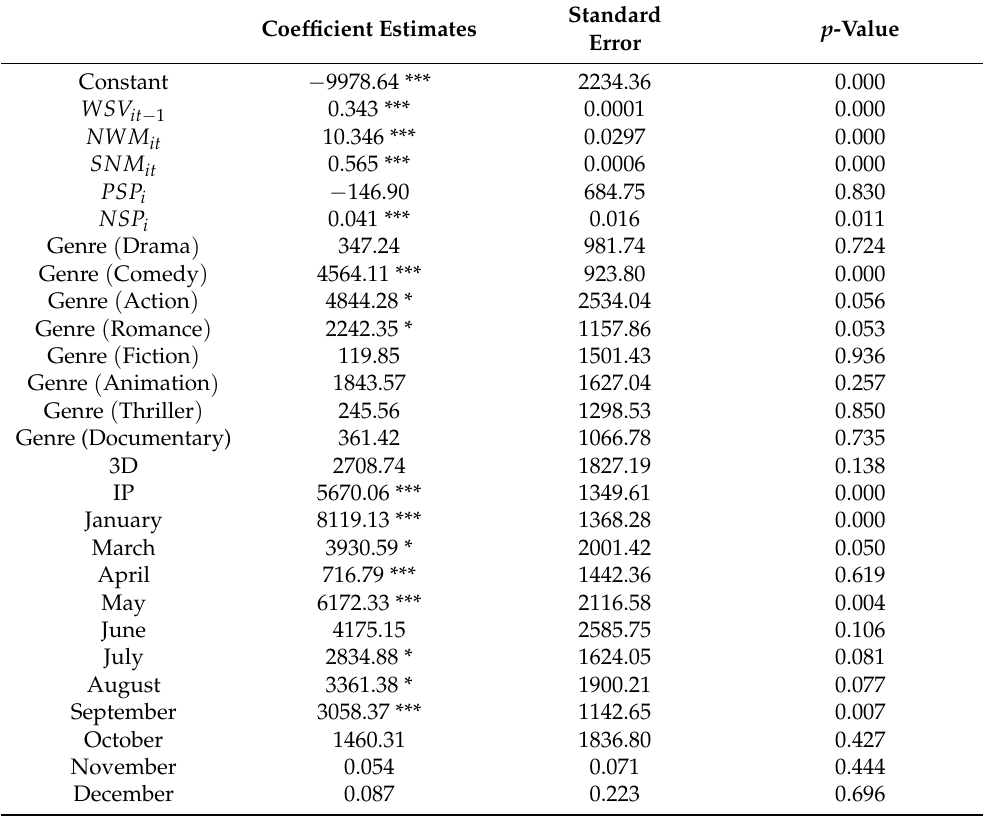
Table 3. Estimation results of AB dynamic panel estimation.